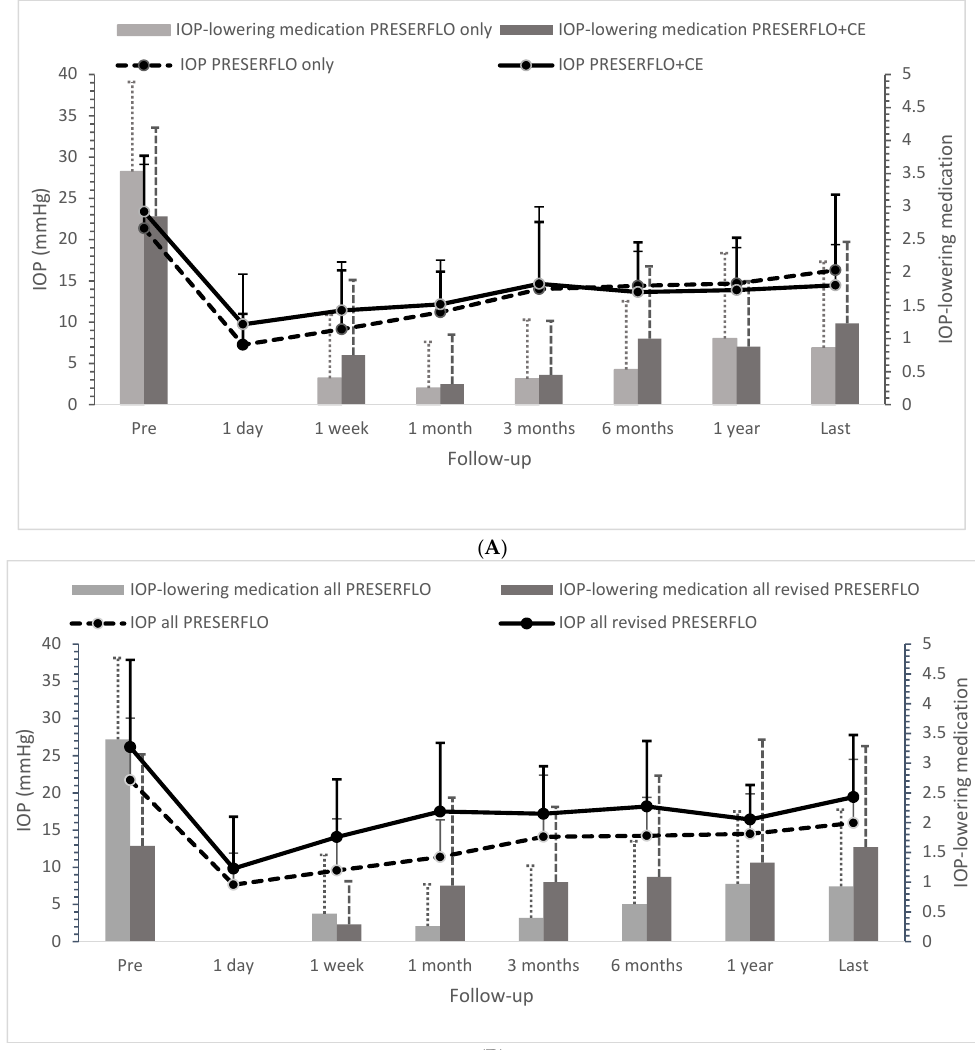
Figure 1. ( A , B ) Mean intraocular pressure (IOP, lines) and mean number of IOP-lowering medication (bars) for PRESERFLO as a standalone procedure vs. as a cataract-combined procedure ( A ) and all Preserflo surgeries (including combined procedures) vs. secondary surgeries (all revised Pre- serflo implants) ( B ). The “last” time interval had a median (interquartile range) follow-up of 1.02 (0.68–1.46) years. The vertical lines represent the standard deviation (SD). IOP = intraocular pressure; CE = cataract